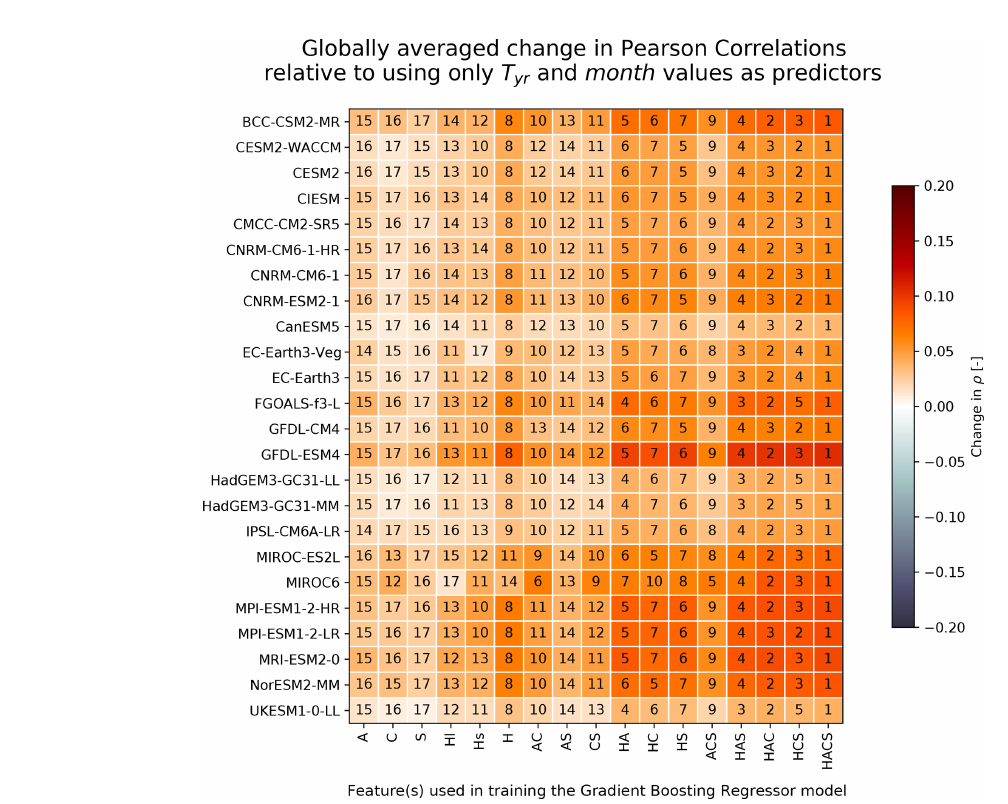
Figure E1. Same as Fig. 12, except that all CMIP6 models are shown for the global land (without Antarctica).